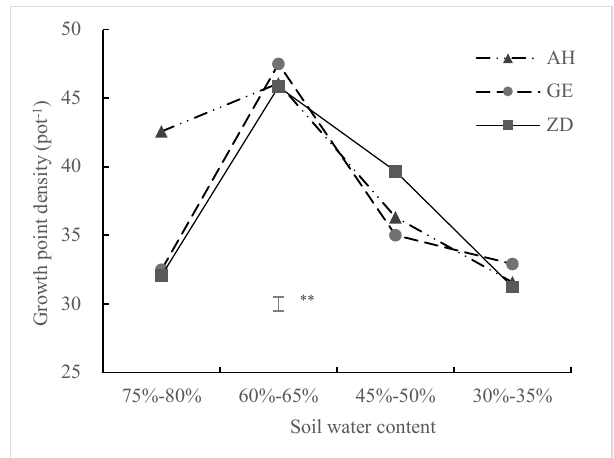
Figure 3. Interaction between soil water content (75 – 80%, 60 – 65%, 45 – 50%, and 30 – 35% of water- holding capacity) and cultivars (AH: Aohan; GE: Golden Empress; ZD: Zhaodong) on alfalfa growing point density (GD). ** p < 0.01.